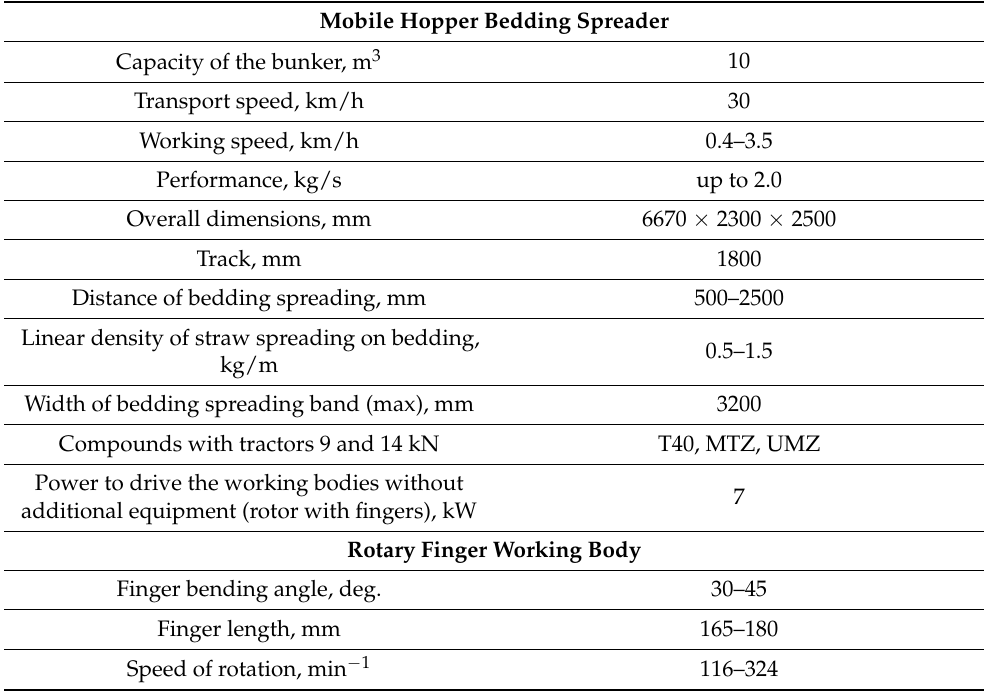
Table 1. Specifications of the equipment with a rotary finger working body for the technological process of making straw